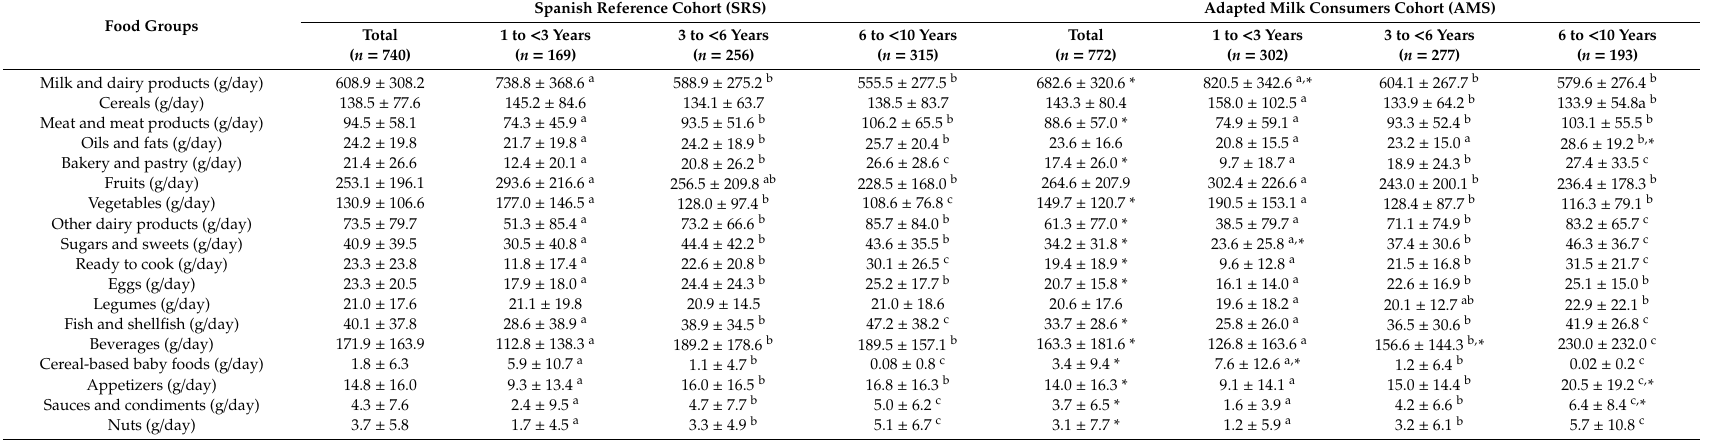
Table 2. Food group consumption according to food frequency questionnaires in the EsNuPI study ( n = 1512). Food